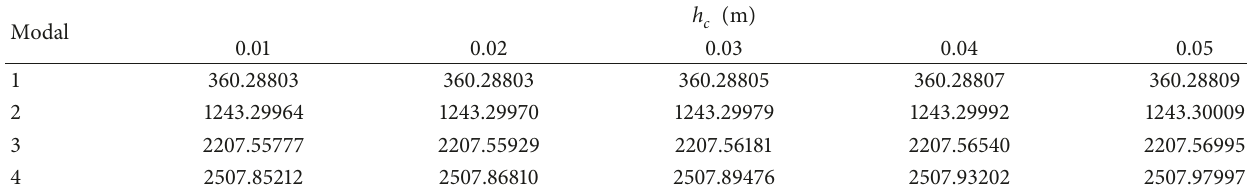
Table 1: Frequencies of different core layer thicknesses of honeycomb sandwich